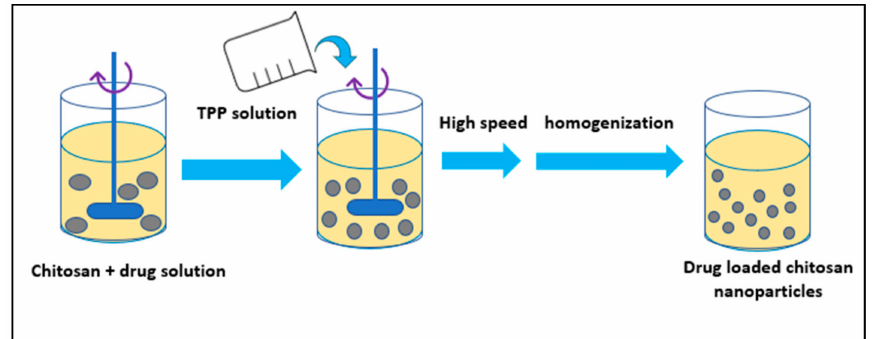
Figure 8. Ion gelation method.